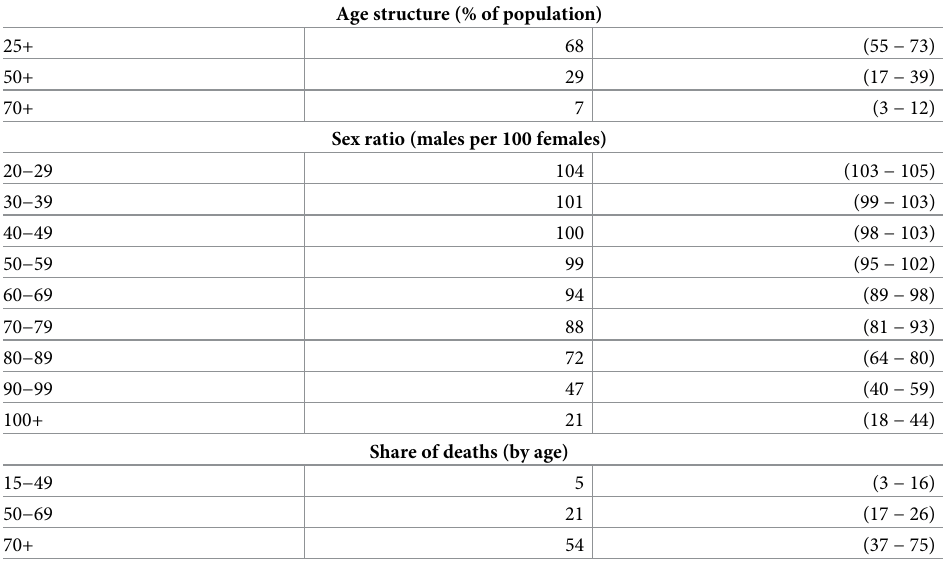
Finally, Table 4 shows a partial list of the risk factors and comorbidities. Our intuition is to correlate COVID-19 death toll motion with an approximation of the size of at-risk group within each country. Prevalence of smoking is based on the population aged 15 years and older who smoke any form of tobacco, including cigarettes, cigars, pipes or any other smoked tobacco products. Obesity is defined as having a body-mass index (BMI) equal to or greater than 30. Diabetes prevalence refers to the percentage of people aged between 20 and 79 years who have type 1 or type 2 diabetes. AIDS prevalence is based on the population aged between Table 3. Data on age structure, sex-ratio by age, and share of deaths by age. For each item it is shown the median fol- lowed by first and third quartiles (calculated over the 211 countries considered in the study). Age structure (% of